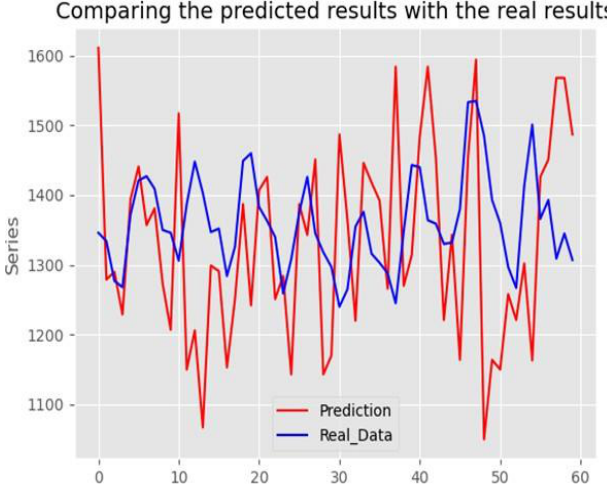
Figure 3 . Prediction of mean traffic for 60 days with L=0